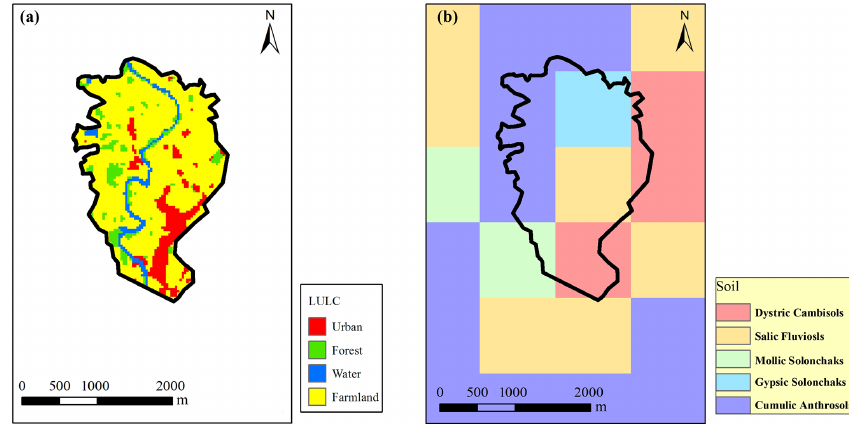
Figure 19. LULC and soil of Helin basin.